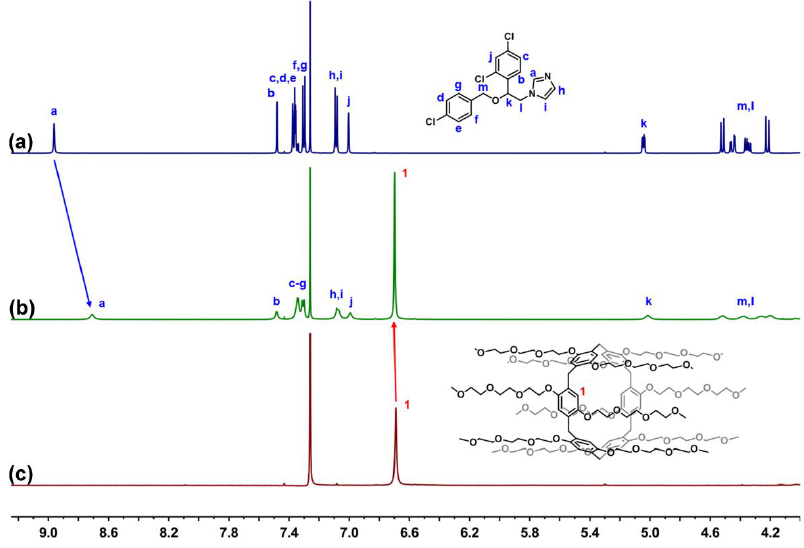
Figure 3. Host – guest complexation studies. 1 H-NMR spectrum (600 MHz, CDCl3) of ( a ) ECN (5 mM) ( b ) ECN (5 mM) + TEP6 (5 mM) and ( c ) TEP6 (5 mM).